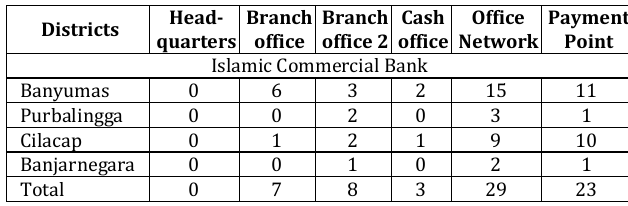
Table 1: Data on the Development of the Number of Sharia Banking Offices in the Purwokerto OJK Work Area as of December 2017